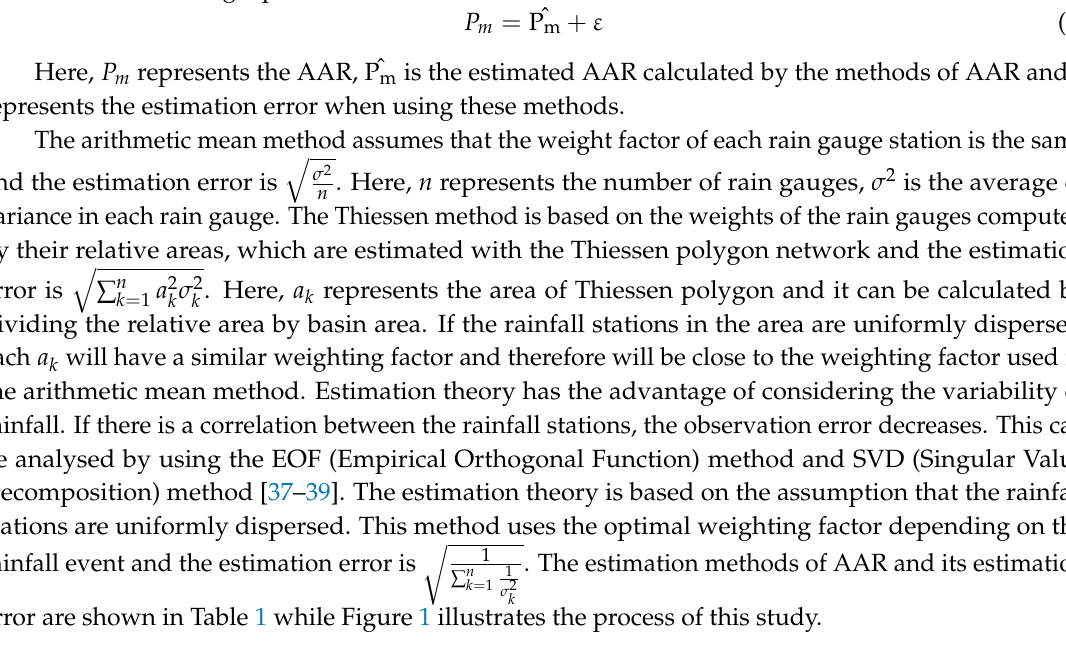
Table 1. Methodology of AAR and its Estimation